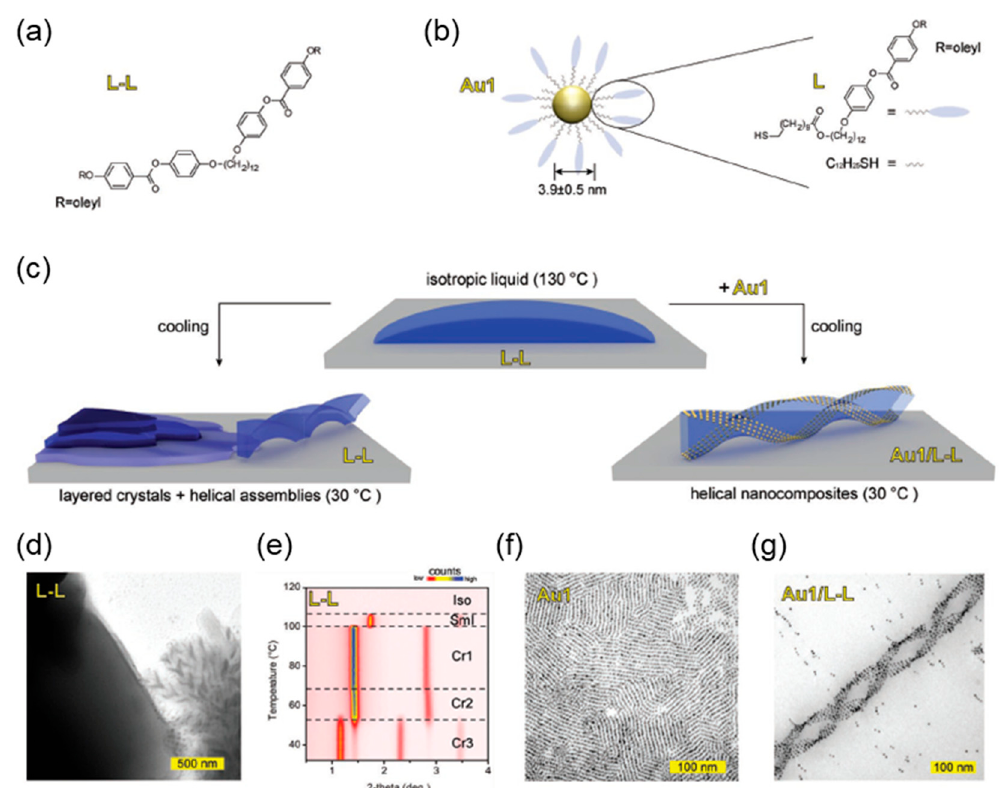
Figure 11. ( a , b ) Chemical structure of bent-shaped LC (L-L) and L-ligand-treated GNP (Au1). ( c ) Sketch of the thermal phase transition of pure L-L and the mixture of L-L and Au1. ( d ) TEM image of pure L-L shows layered crystal and HNFs. ( e ) 1D-XRD results of L-L depending on the temperature. TEM images of ( f ) Au1 and ( g ) the mixture of L-L and Au1. Reprinted with permission from [45], Copyright 2019, Wiley-VCH.